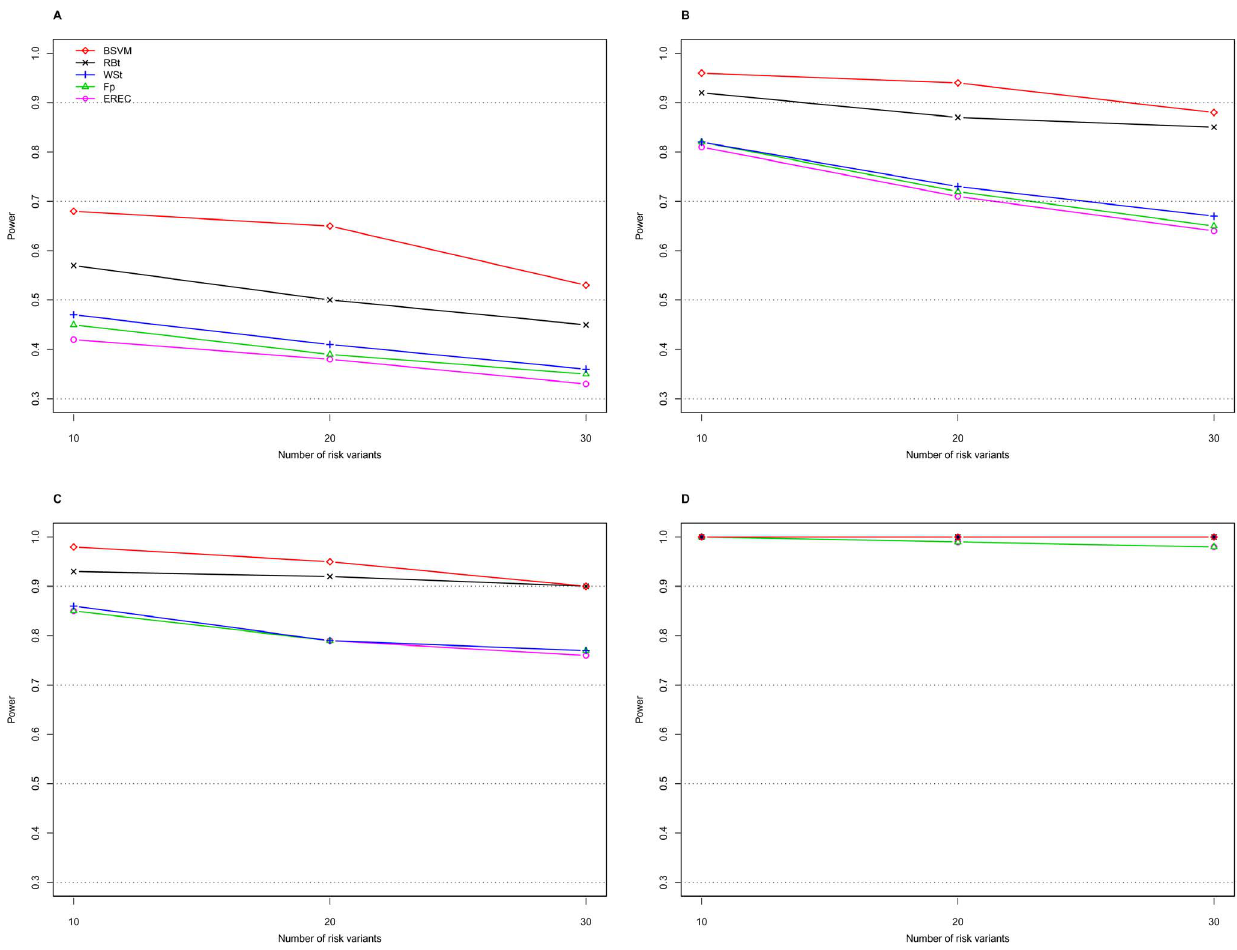
Figure 1. Power of the five approaches with equal PARs in the presence of different numbers of risk variants. A. PAR=0.03 with a sample size of 1000; B. PAR=0.05 with a sample size of 1000; C. PAR=0.03 with a sample size of 2000; D. PAR=0.05 with a sample size of 2000. The nominal level is 0.05.